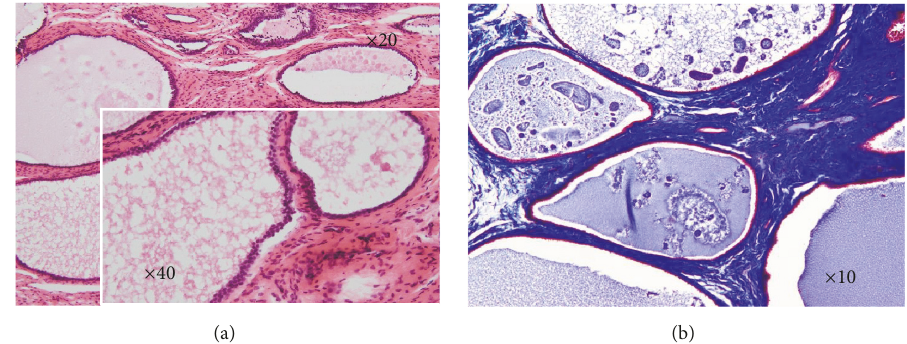
Figure 4: Microscopic findings, showing that (a) the tumor resulted from the benign biphasic proliferation of epithelial and mesenchymal components. The epithelial elements were endometrial glands of benign appearance (HE stain, objective magnification × 20). The inset shows that the mesenchymal component consisted of endometrial stroma containing fibroblasts of benign nuclear features and very low mitotic activity (HE stain, objective magnification × 40): (b) the mesenchymal part was strongly positive on Masson’s trichrome staining, confirming the presence of collagen fibers (Masson’s trichrome stain, objective magnification × 10).